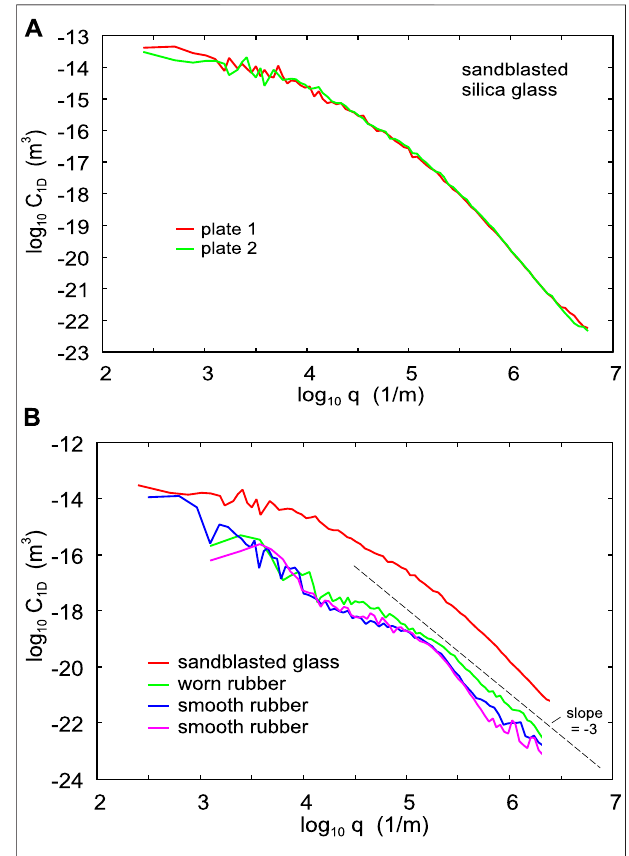
FIGURE 3 | (A) The 1D surface roughness power spectrum of the sandblasted glass plate 1 (red) and glass plate 2 (green). The rms roughness of both plates is ≈ 15 μ m. (B) The 1D surface roughness power spectrum of the sandblasted glass surface (red) and of the smooth (before tests) rubber surface (blue and pink), and of the rubber surface after the sliding friction measurements on the sandblasted surface